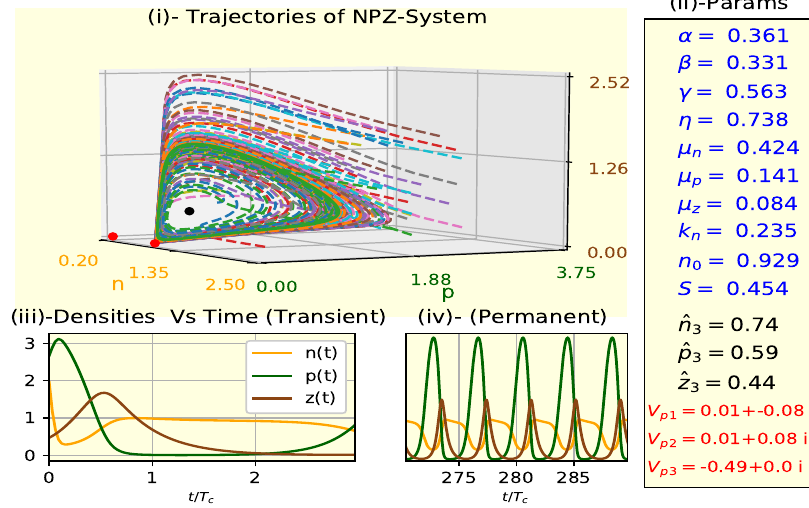
Fig. 5: e 3 Unstable: (i)-Some orbits in the phase space. The point in black is the equilibrium e 3 and in red the two others . (ii)- System parameters (blue), coordinates of e 3 (black) and associated eigenvalues (red). (iii)-Density evolution vs time transient phase and (iv) permanent phase.